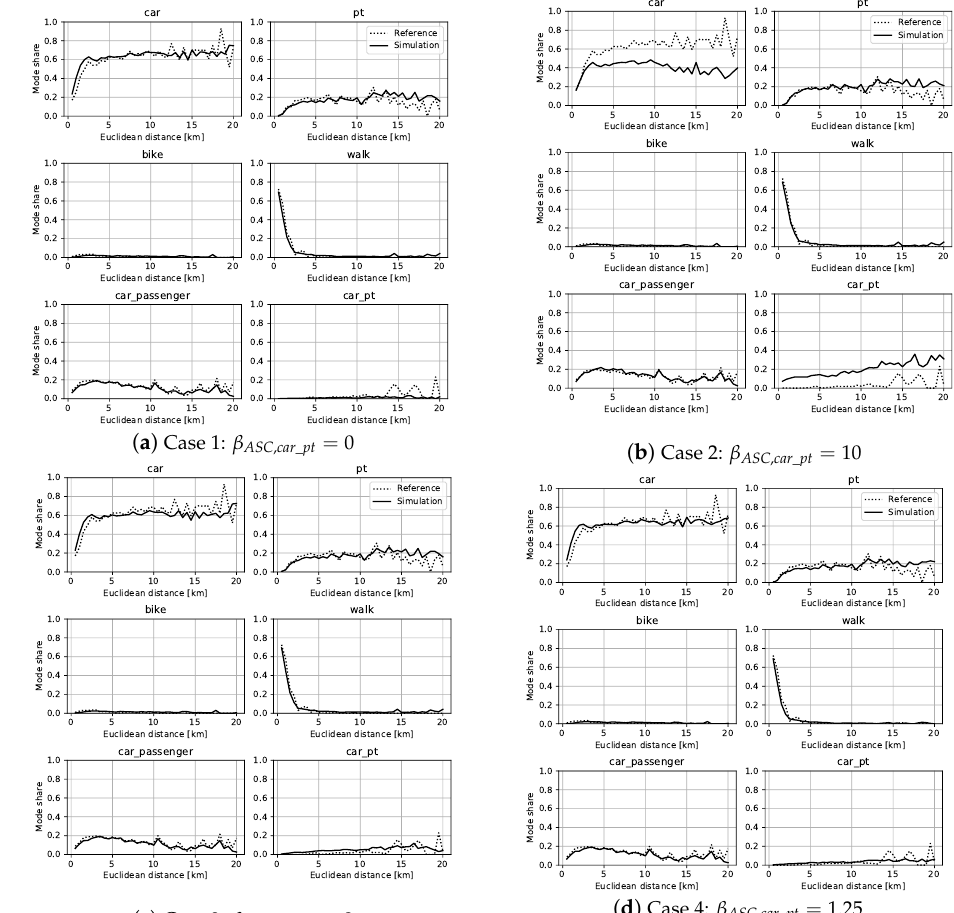
Figure 5. Modal shares during the calibration step for different values of β ASC , car_pt .